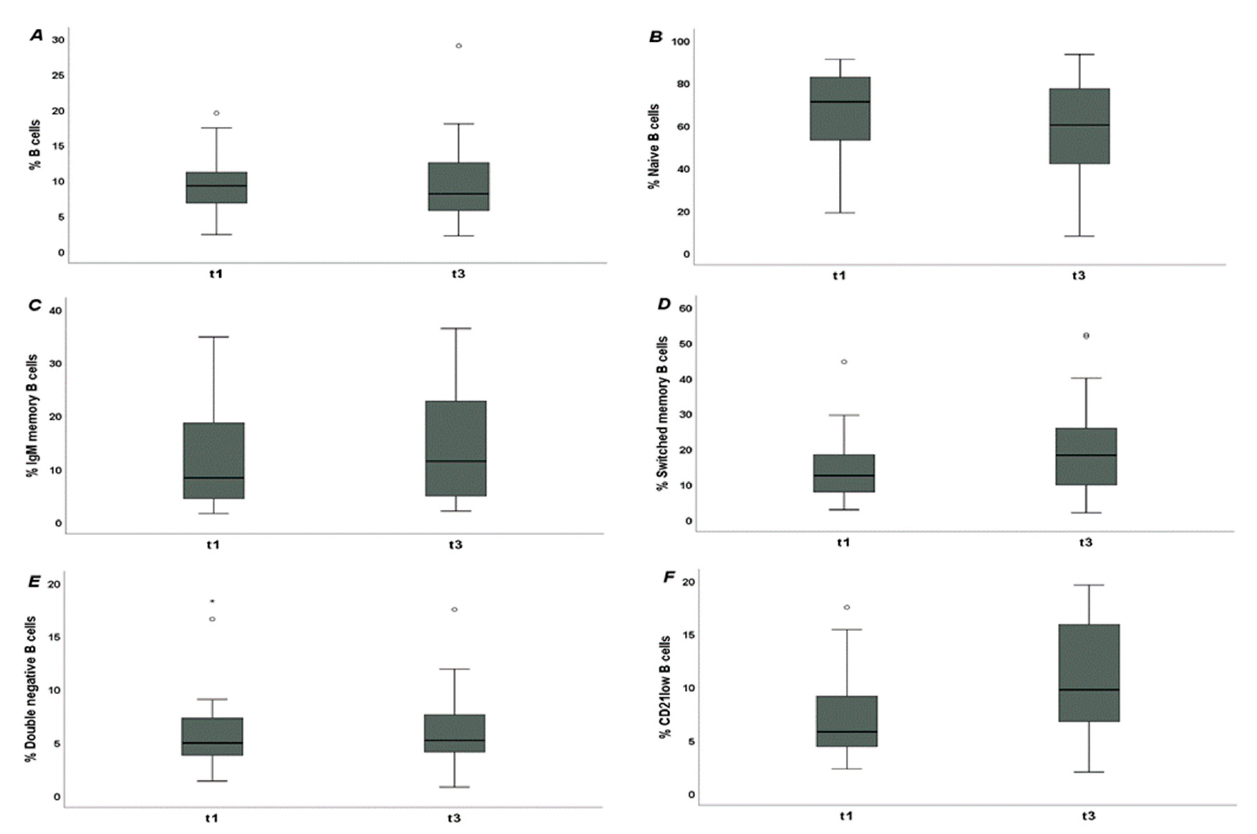
Figure 2. B cells in systemic sclerosis (SSc) patients before (t1) and 3 months after SARS-CoV-2 mRNA vaccine (t3). ( A ): percentage of B cells [8.1% (IQR 5.75–12.5) vs. 7.53% (IQR 5.87–11.5), p > 0.05]; ( B ): percentage of naive B cells [60.2% (IQR 41.95–77.25) vs. 70.55% (IQR 47.15–80.2), p < 0.01]; ( C ): percentage of IgM-memory B cells [11.45% (IQR 4.9–22.75) vs. 8.57% (IQR 4.62–19.15), p < 0.05]; ( D ): percentage of switched-memory B cells [18.25% (IQR 9.85–25.85) vs. 14.15% (IQR 8.5–20.2), p < 0.001]; ( E ): percentage of double-negative B cells [5.2% (IQR 4.1–7.6) vs. 5.16% (IQR 3.78–7.76), p > 0.05]; ( F ): percentage of CD21 low B cells [9.75% (IQR 6.77–15.9) vs. 5.59% (IQR 3.84–9.13), p < 0.001].